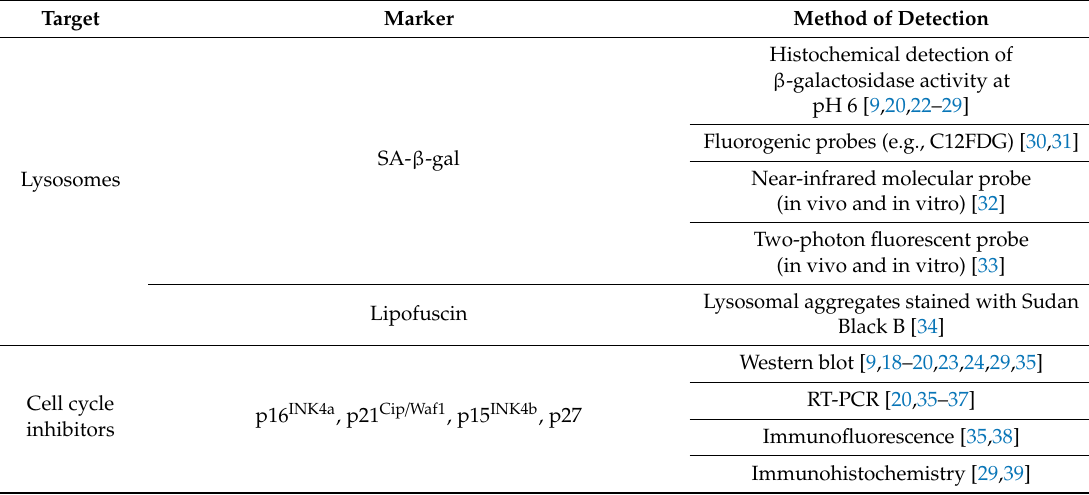
Table 1. Summary of methods for the detection of senescent